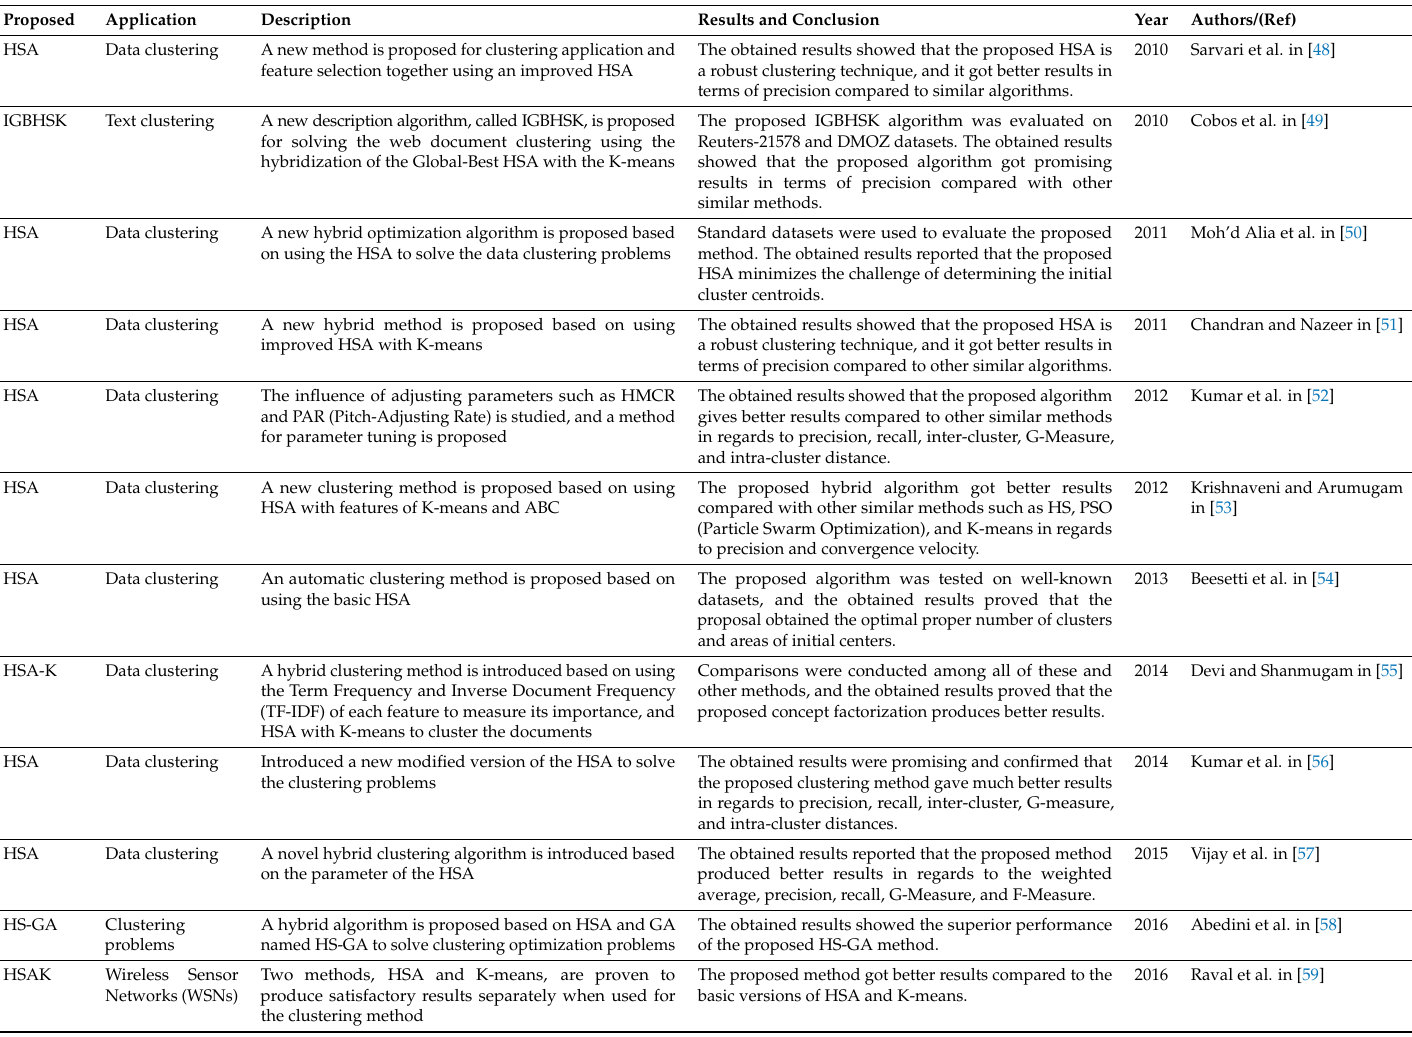
Table 1. Variants of the